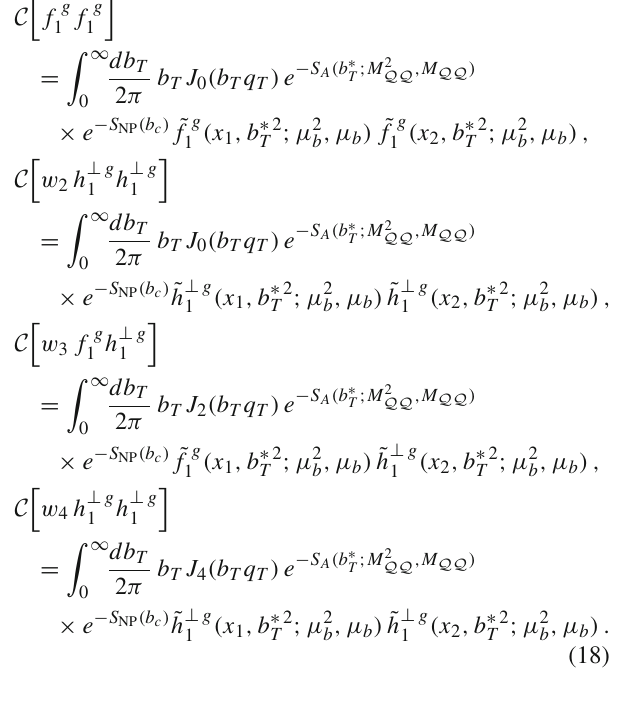
for M QQ = 8 GeV using the range of b T lim between 2 and